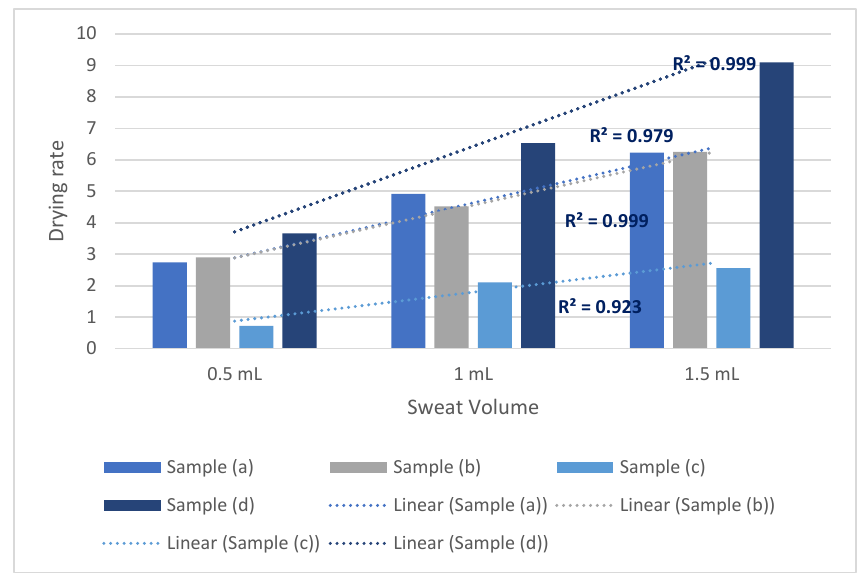
Figure 5. Sweat drying performance of protective fabrics at 1.0 m/s ambient air speed.